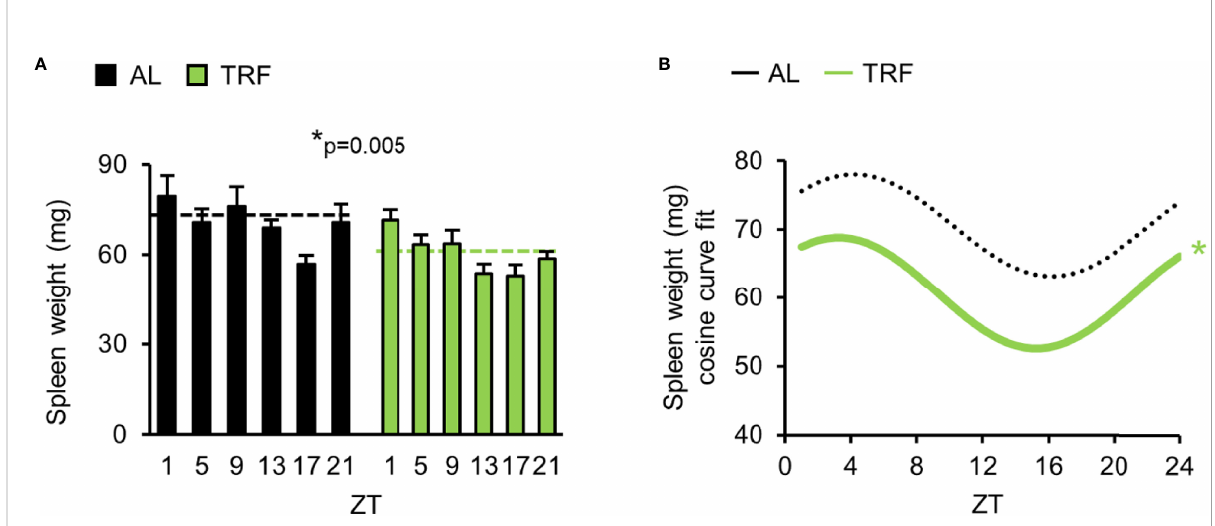
FIGURE 2 Time restricted feeding reduces spleen weight. (A) Spleen weight in the course of the day after the 4-week feeding regimens (mean + SEM, n = 3-11 (AL), n = 6-13 (TRF), two-way ANOVA, time effect p = 0.008, * indicates the signi fi cant group effect). Dashed lines indicate the daily average spleen weight. (B) Cosine curve fi t to data showed in (A) , * and the solid line indicate signi fi cant, fi xed 24-hour period cosine curve fi t with cosinor analysis, whereas dashed line shows non-signi fi cant fi t. Parameters of the fi tted cosine curves are listed in Supplementary Table 3. ZT, Zeitgeber